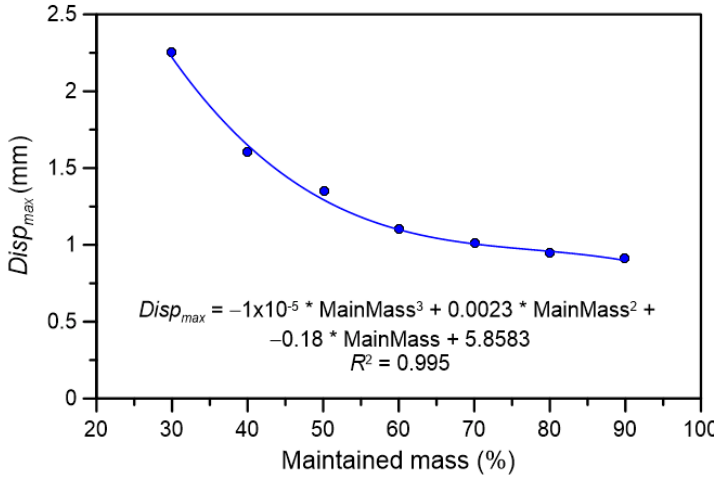
Figure 10. Maintained mass vs. maximum displacement for experiment OT1.